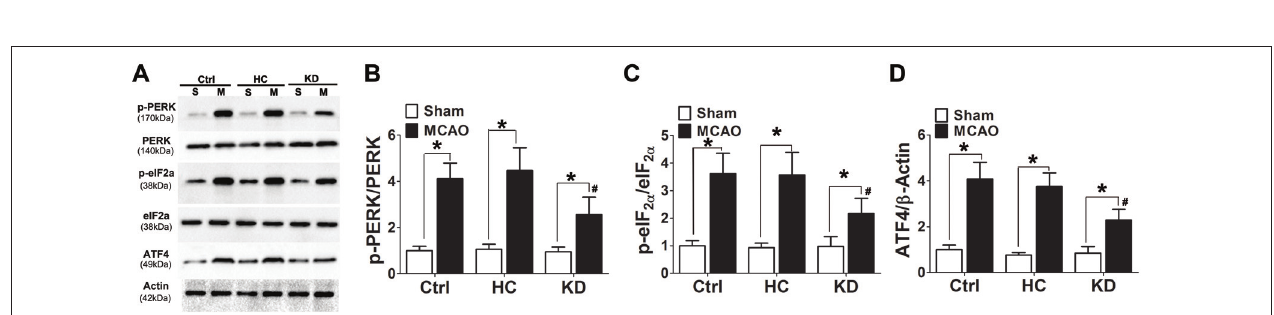
FIGURE 7 | KD suppressed the p-PERK-p-eIF2 α -ATF4 pathway in MCAO mice. Sham-operated and MCAO mice ( n = 6 per group) were fed with different diet protocols and Western blotting (A) was used to determine the protein expression of p-PERK/PERK (B) , p-eIF2a/eIF2a (C) and ATF4/ β -actin (D) . Representative blots from six independent experiments with similar results are shown. Data are shown as mean ± SEM; ∗ P < 0.01 vs. sham-operated mice, # P < 0.05 vs. MCAO